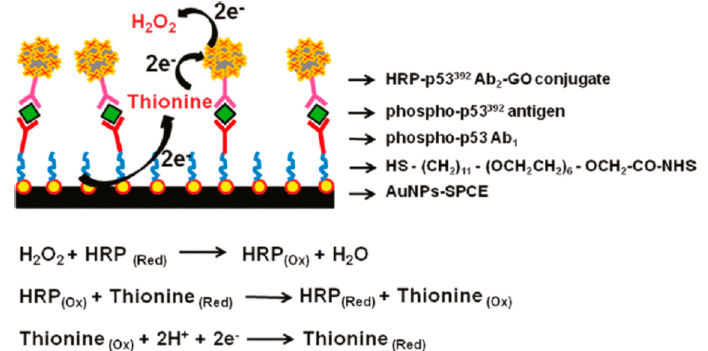
Figure 5. Schematic Illustration of the Multi-enzyme Labeling Amplification Strategy Using HRP-p53392Ab2-GO Conjugate. Reproduced with permission [110]. Copyright 2011, American Chemical Society.